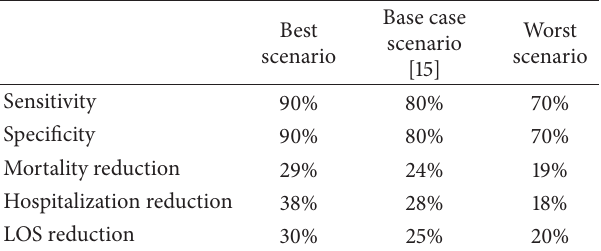
Table 4: Telehealth clinical efficacy